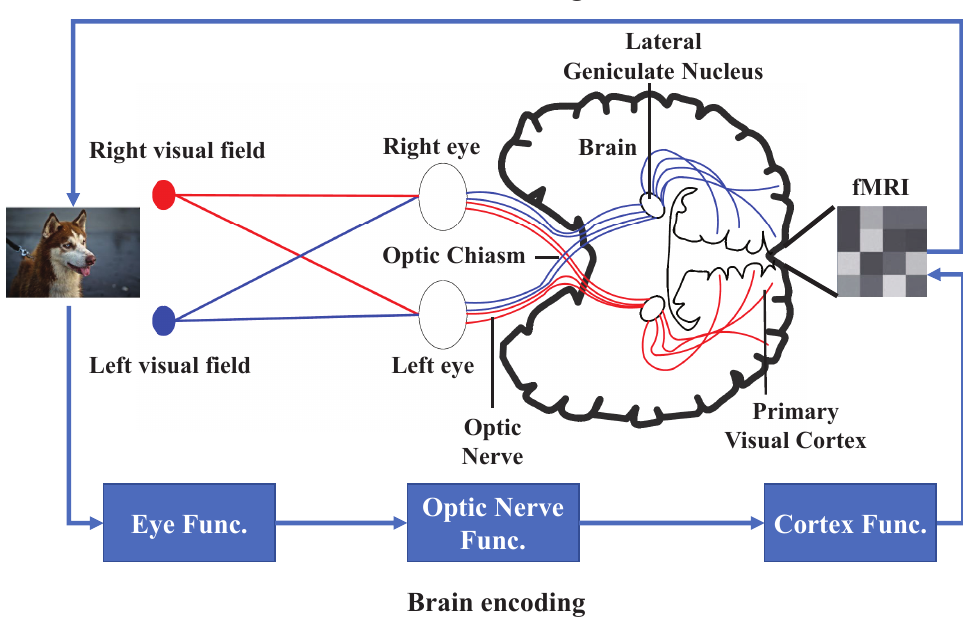
Figure 1. Visual